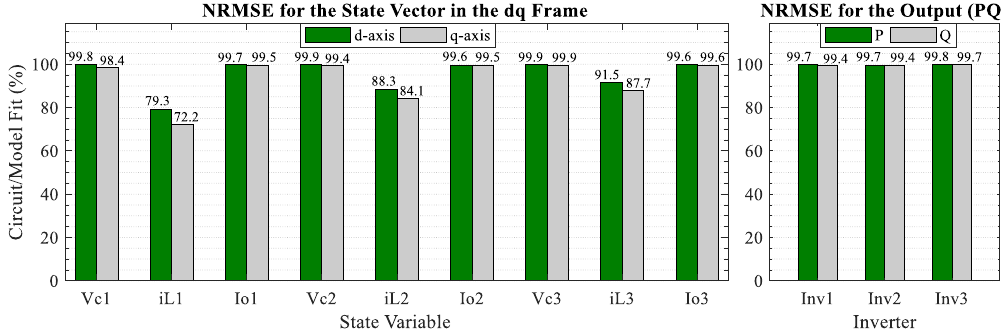
Figure 14. NRMSE for the state vector and shared power.